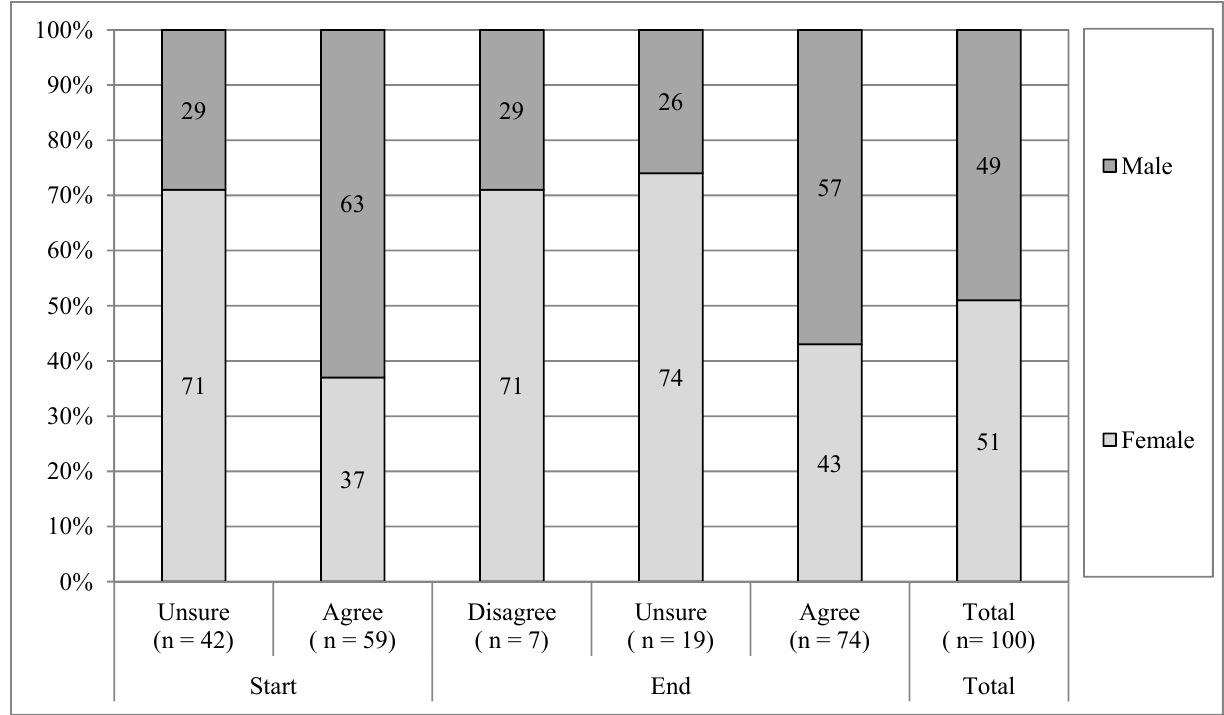
Figure 5. Gender by attitude